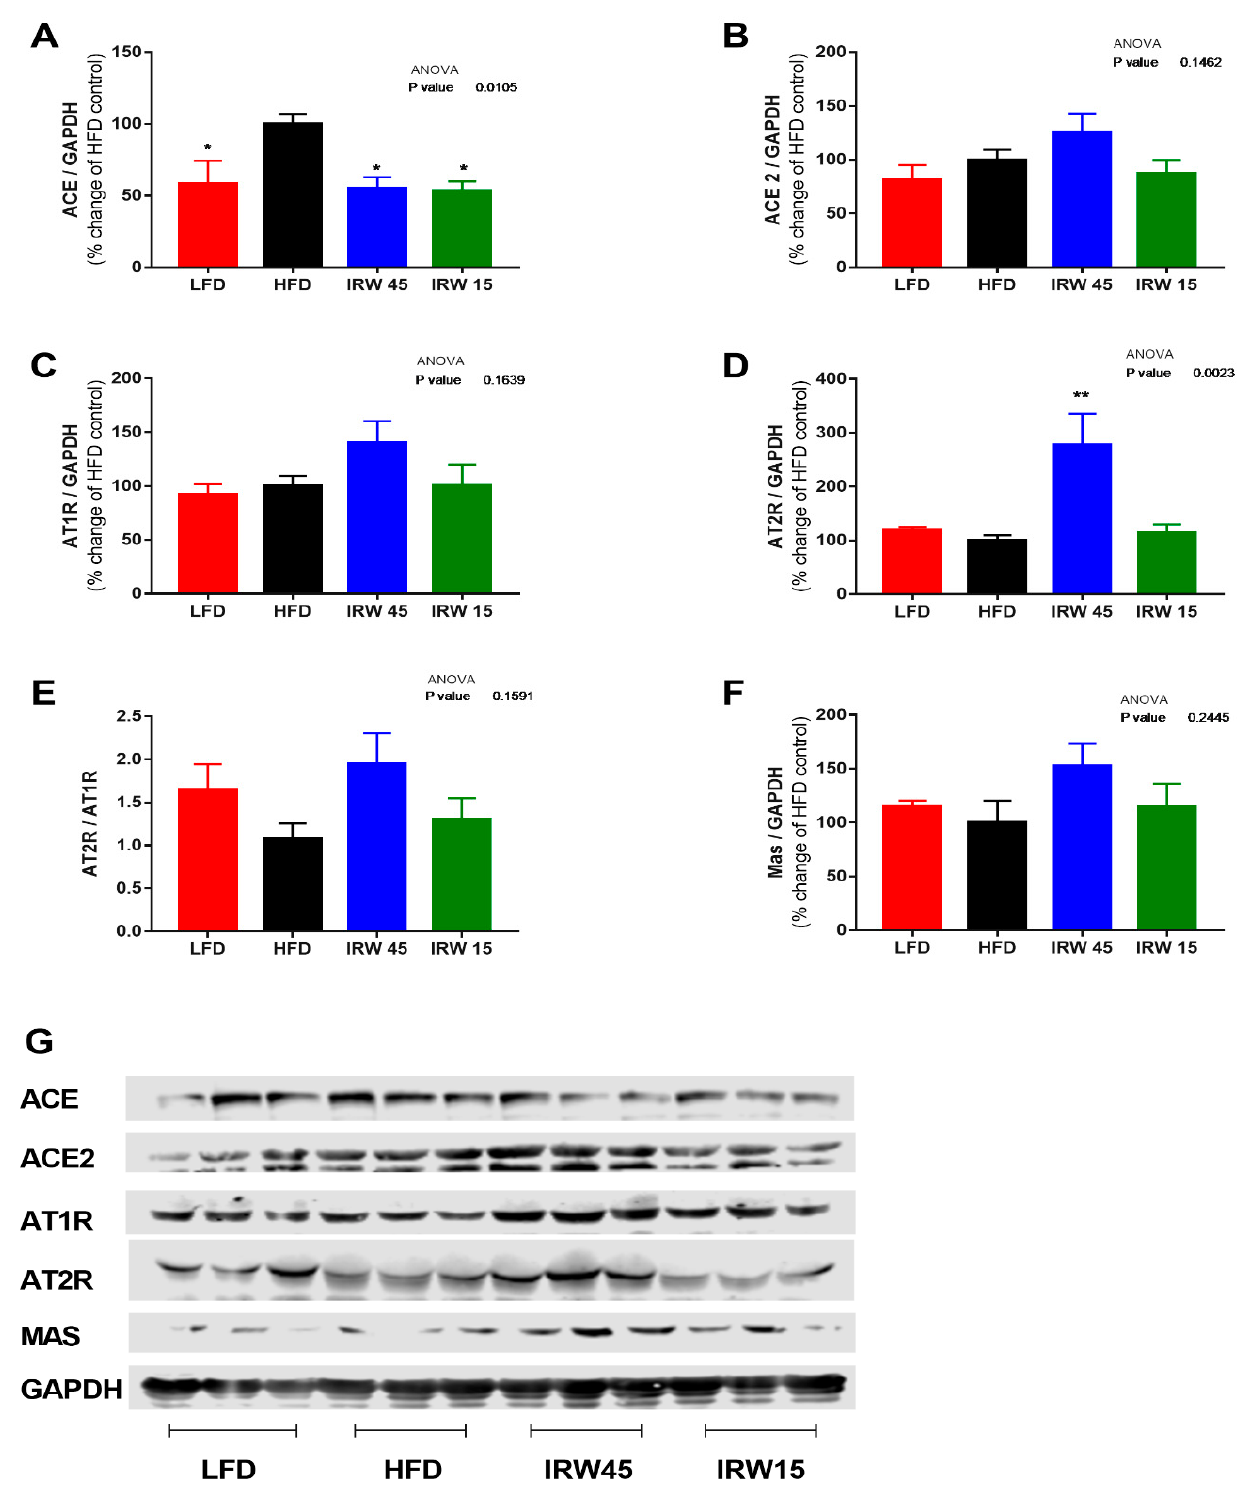
Figure 3. Skeletal muscle renin angiotensin system components. ( A ) ACE, ( B ) ACE2, ( C ) AT1R, ( D ) AT2R, ( E ) AT2R/AT1R ratio, ( F ) Mas receptor, and ( G ) representative blot. ACE, ACE2, AT1R, AT2R, and Mas were normalized to GAPDH. Data expressed as mean ± SEM of n = 5–6 mice. Analysis by one-way ANOVA followed by Bonferroni’s post-hoc test. * p < 0.05 and ** p < 0.01 versus HFD. ACE, angiotensin converting enzyme; ACE2, angiotensin converting enzyme 2; AT1R, angiotensin receptor type 1; AT2R, angiotensin receptor type 2.